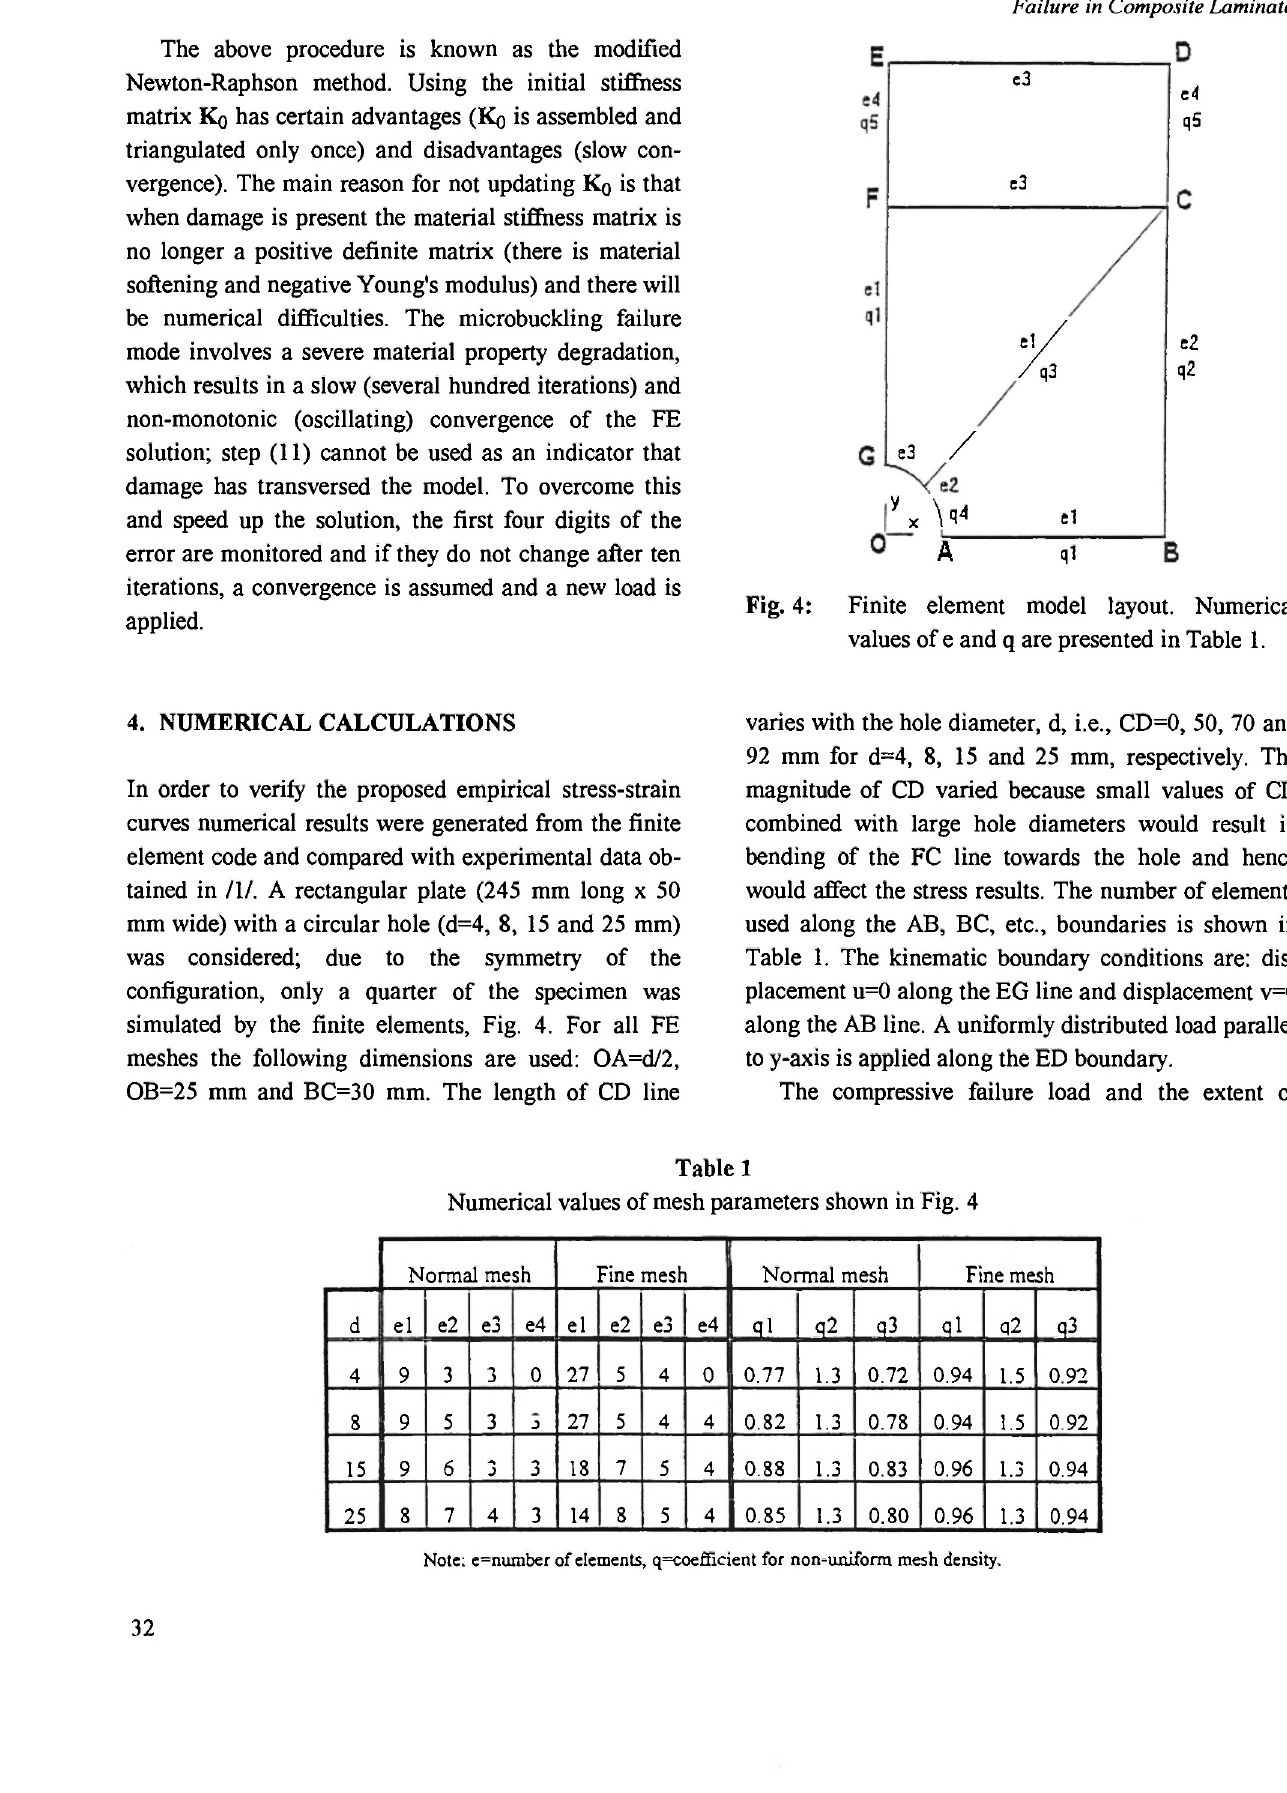
Numerical values of mesh parameters shown in Fig.